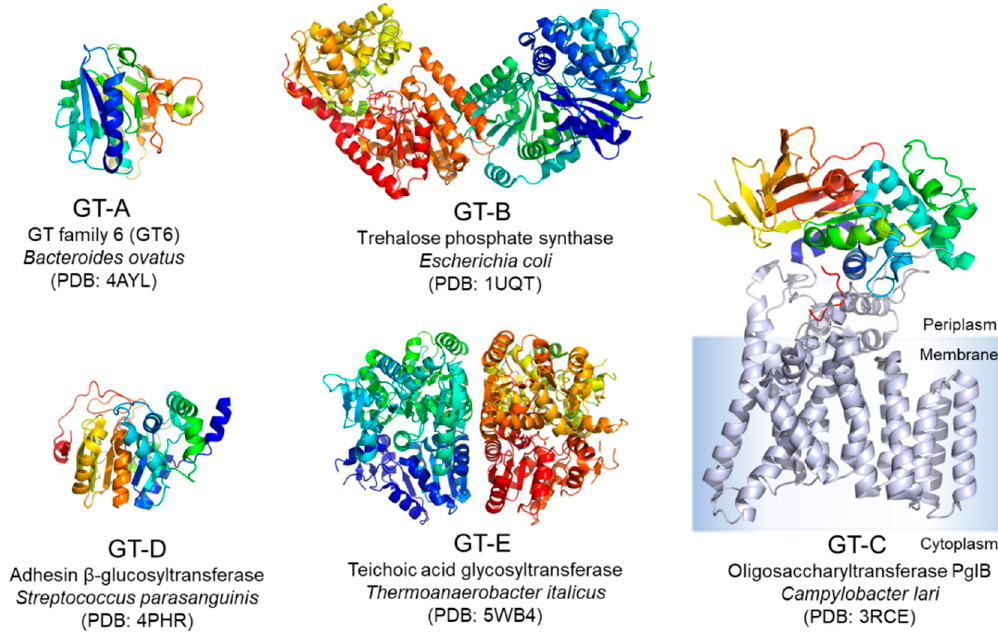
Figure 3. Protein folds of Leloir glycosyltransferases (GT-A, GT-B, GT-D) and non-Leloir glycosyltransferases (GT-C, GT-E).